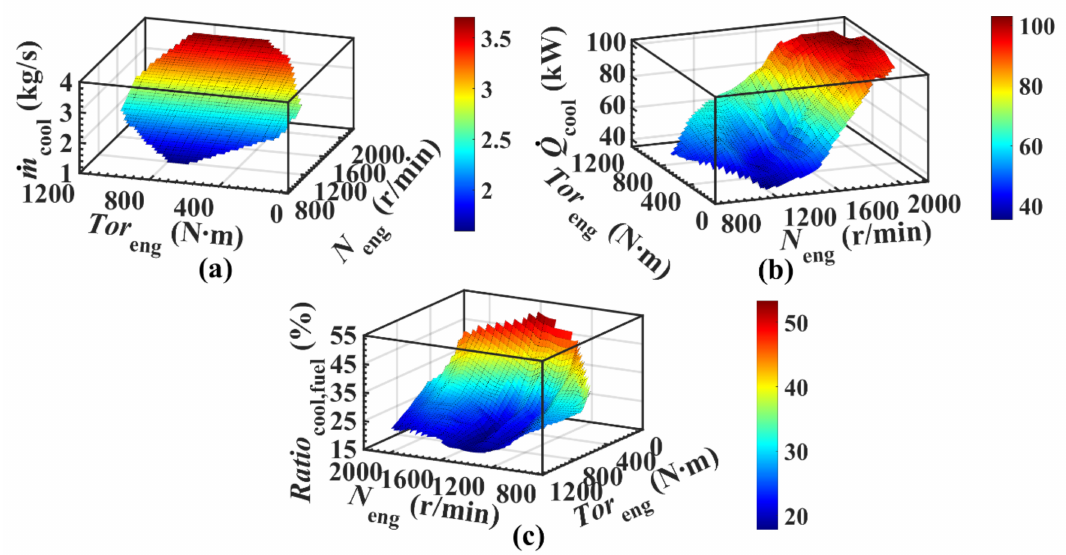
Figure 4. Dynamic characteristics of coolant waste heat under full operating conditions. ( a ) distribution characteristics of the coolant mass flow rate. ( b ) coolant heat transfer rate distribution characteristics. ( c ). proportion of the coolant heat transfer rate to the energy released by fuel